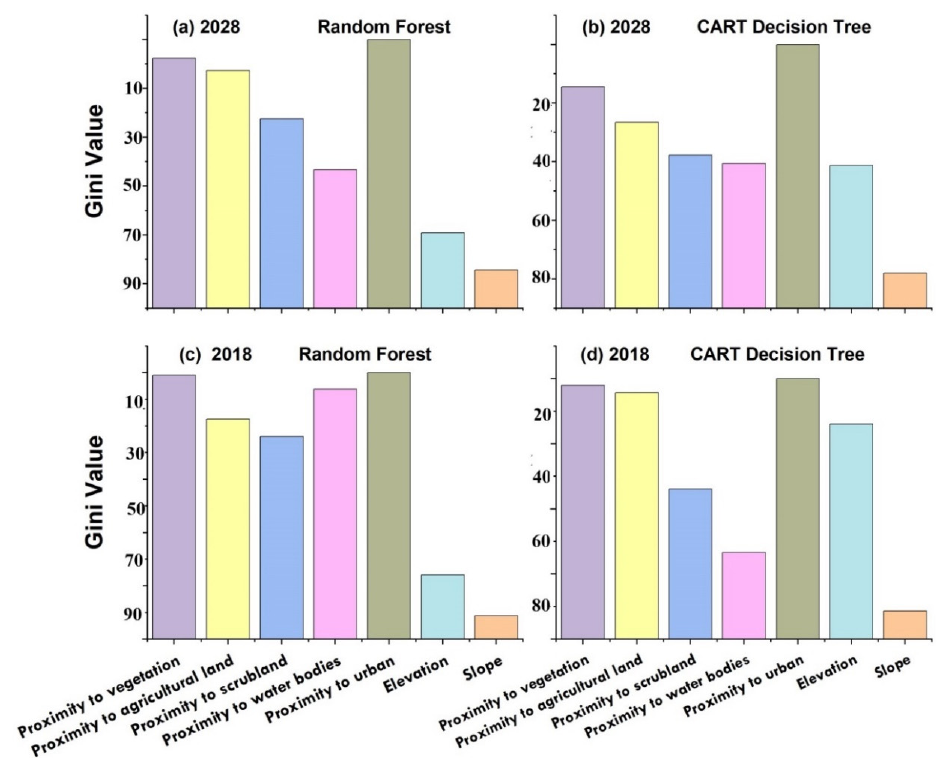
Figure 4. Sensitivity analysis for projected LULC of 2028 ( a , b ) and simulated LULC of 2018 ( c , d ) using RF and